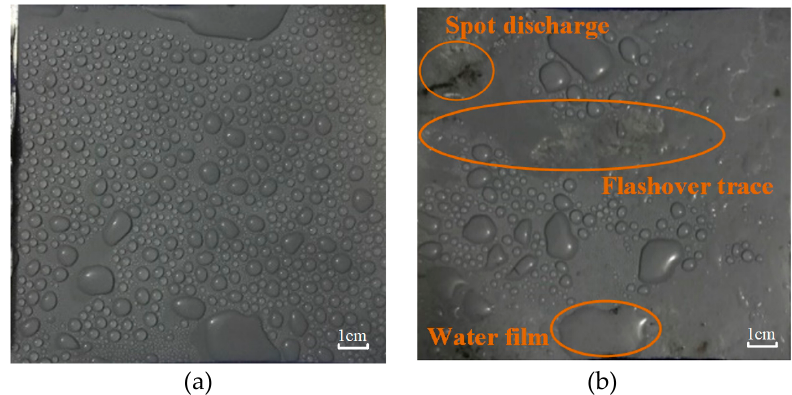
Figure 7. Surface states of the samples after salt-fog treatment. ( a ) Unenergized (0 kV), ( b ) energized (DC 3.2 kV).